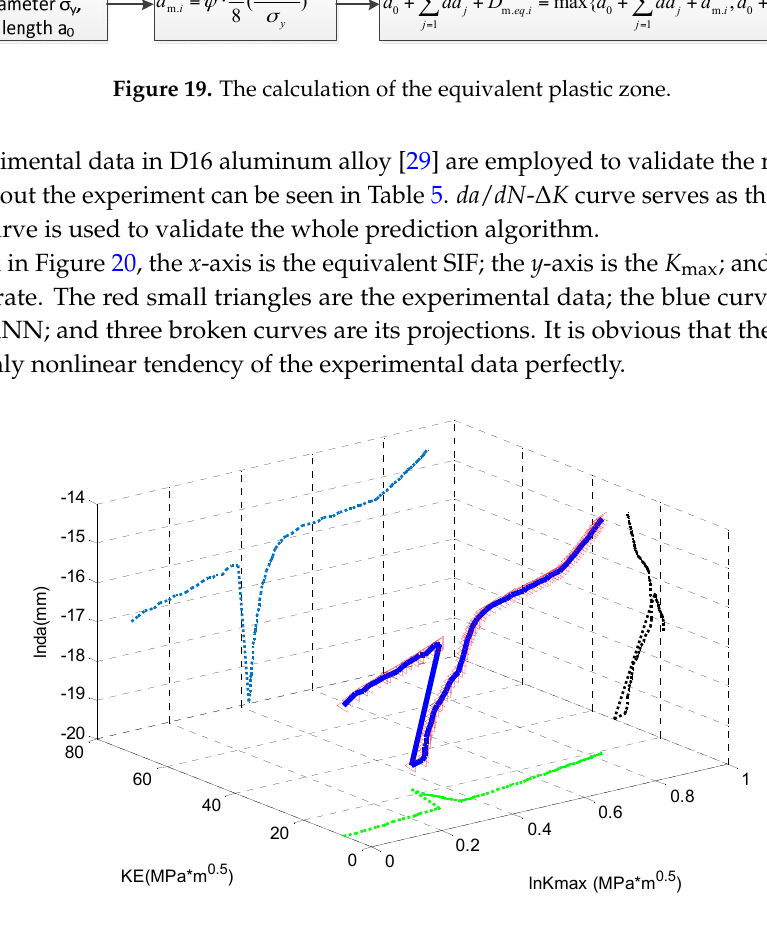
Figure 20. The fitting vs. the experimental data for D16 aluminum alloy.